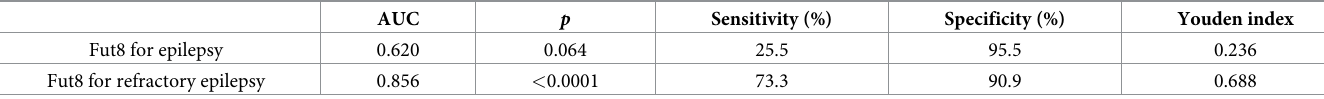
Table 2. Evaluating epilepsy and refractory epilepsy by Fut8.